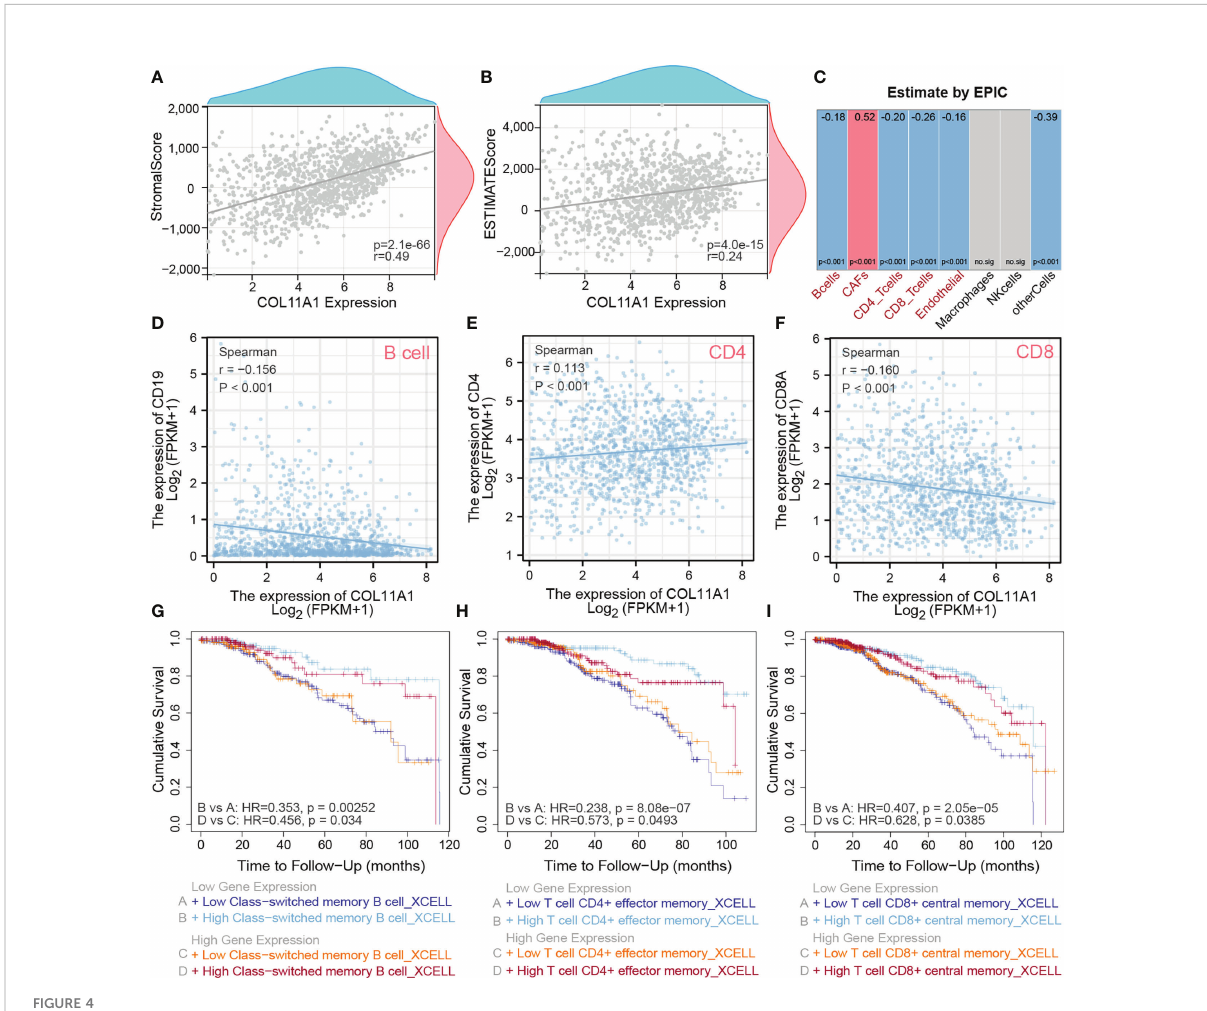
FIGURE 4 High expression COL11A1 Promote tumor immune in fi ltration. COL11A1 was signi fi cantly positively correlated with a stromal score(r=0.49, p<0.001) and estimate score(r=0.29,p<0.001) in the tumor microenvironment (A, B) . COL11A1 expression was negatively correlated with B cells, CD4, and CD8 and positively correlated with CAFs (C) . COL11A1 was signi fi cantly negatively correlated with the marker of B cells, positively correlated with a marker of CD4, and negatively correlated with a marker of CD8 (r=-0.156, r=0.113 and r=-0.160, respectively; p<0.001) (D – F) . The in fi ltration level of B-cell, CD4 and CD8 cells, were negatively with patient prognosis,no matter COL11A1 expression status (G – I)